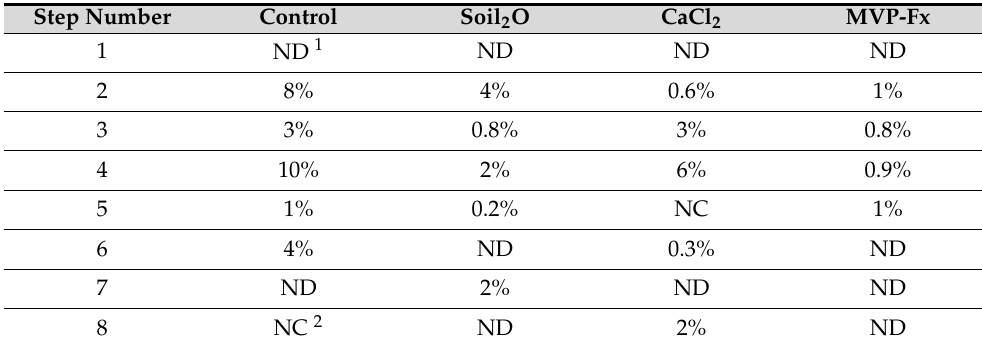
Table 10. Percent transfer of walking experiments to sand and non-sand.